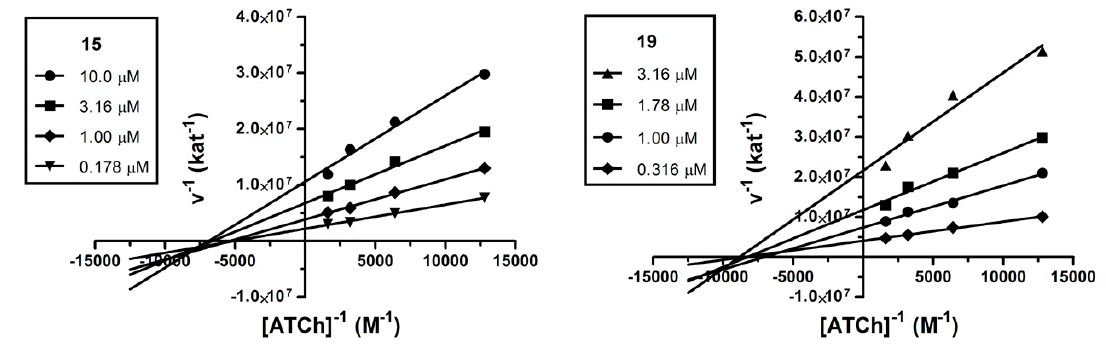
Figure 3. Steady-state inhibition of AChE hydrolysis of acetylthiocholine (ATCh) by compounds 15 and 19 . Lineweaver-Burk reciprocal plots of initial velocity and different substrate concentrations (0.781–6.25 mM) are presented. Lines were derived from a weighted least-squares analysis of data.